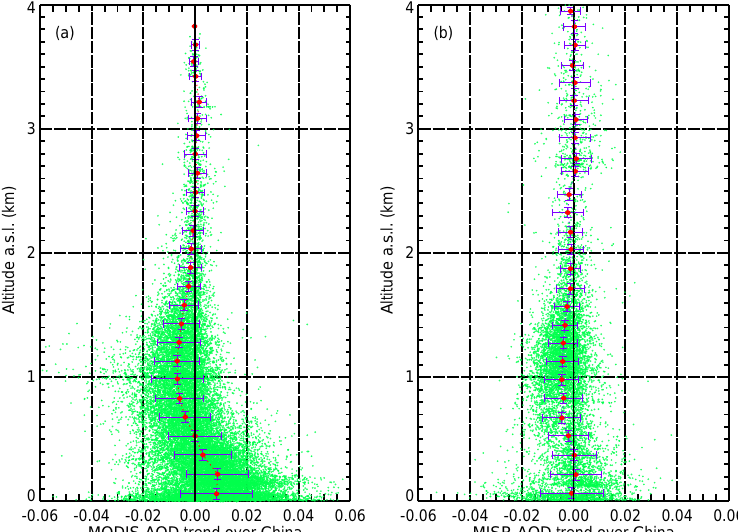
Figure 3. Vertical profiles of aerosol optical depth (AOD) trends over the entirety of China from (a) MODIS and (b) MISR retrievals in the summer seasons of 2002 to 2014. Red dots and horizontal bars represent mean tendencies and standard deviations, respectively. The “a.s.l.” in the ordinate labels stands for “above sea level”. The specific region of study can be found in Fig. S2 in the